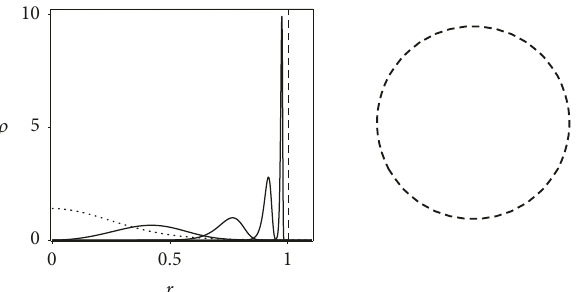
Figure 6: The energy density of (45) for 𝛽 = 8 , 𝛼 = 0.2 and several values of 𝑙 (left) and its compact limit, 𝑙 󳨀→ ∞ , in the plane (right). The dotted line represents the case 𝑙 = 1 and the dashed ones stand for the compact limit in